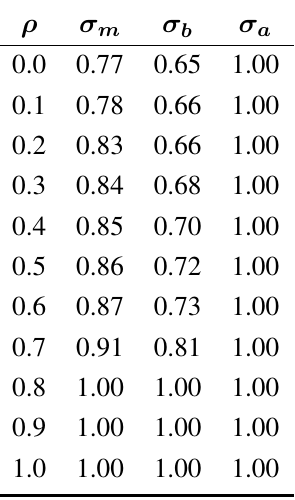
Table 3. Speeds for different static power ratio. MTBF = 5 years, N = 100,000, W = 1 h, t = 1.3 h, t = 2.6 h. R 1 R 2